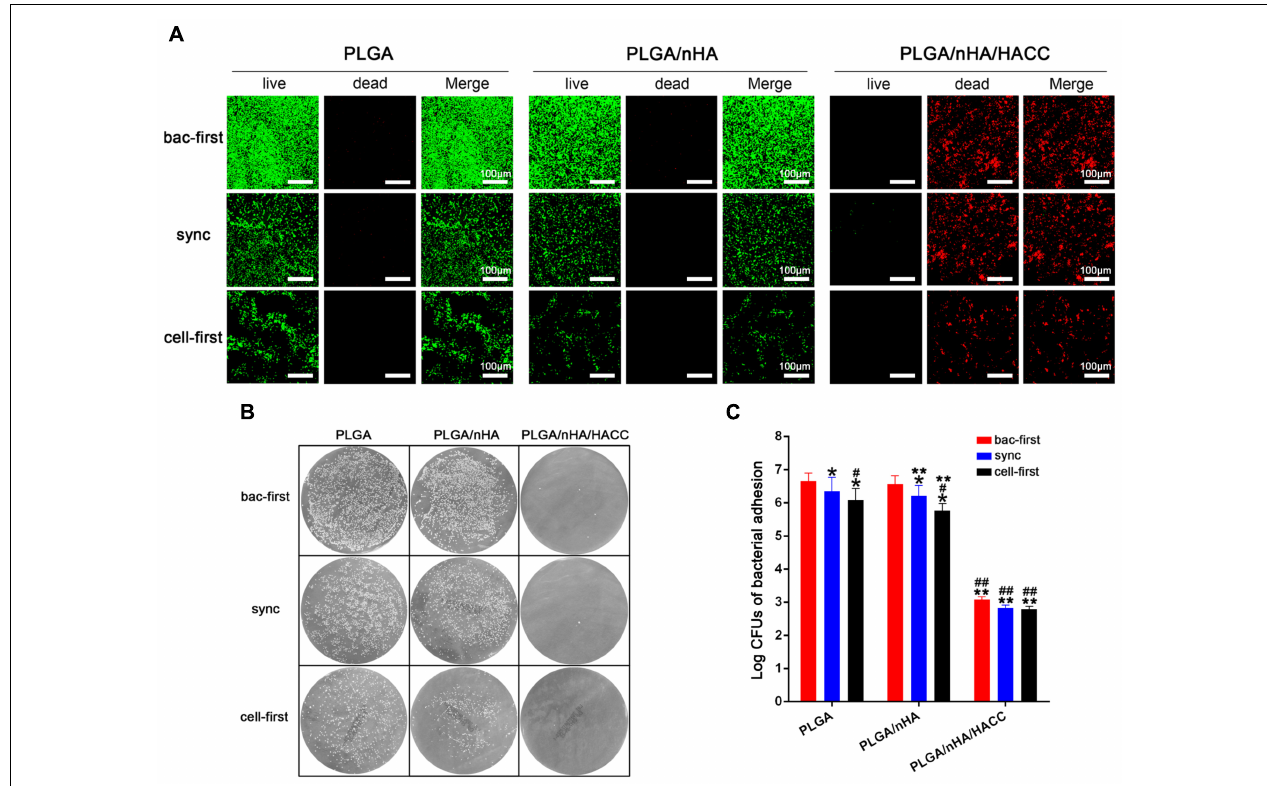
FIGURE 5 | Qualitative and quantitative analyses of S. aureus on different materials surfaces in the different co-cultured systems. (A) Qualitative analysis of bacterial viability on surfaces by the Live/Dead BacLight viability kits. Representative images of live bacteria (green fluorescence) and dead bacteria (red fluorescence). (B,C) Quantitative analysis of bacterial viability on surfaces by the spread plate method. ∗ p < 0.05 compared with bac-first group on the same surface. # p < 0.05 compared with sync group on the same surface. ∗∗ p < 0.05 compared with PLGA group in the same co-cultured system. ## p < 0.05 compared with PLGA/nHA group in the same co-cultured